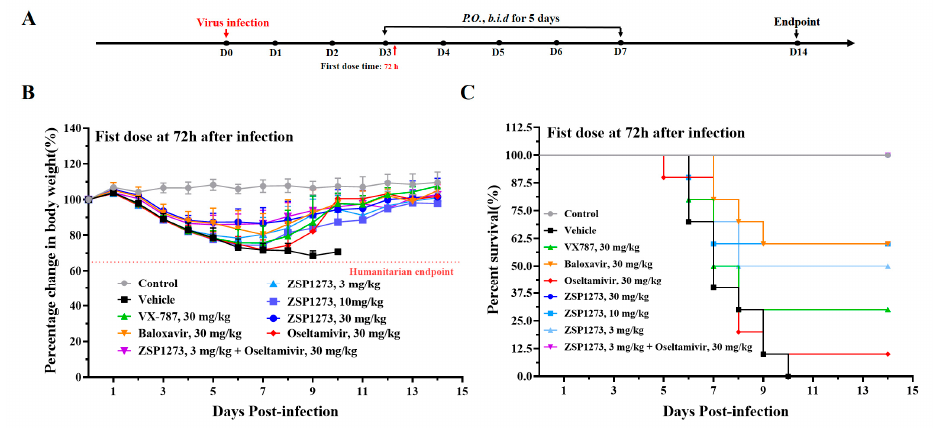
Figure 7. The antiviral activity of ZSP1273 in murine infection experiment IV (n = 10, mean ± SEM): ( A ) Flowchart of the experiments: the day of H1N1 infection is defined as day 0, the first day after infection is denoted as day 1, and so forth. ( B , C ) Changes in the weight and survival rate, respectively, of mice in each group after infection. Based on the weight on the day of infection, a mouse with more than 35% weight loss (indicated by the dashed line) would be considered dead, according to the IACUC.